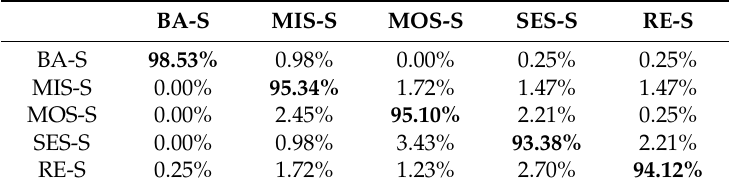
Table 6. Classification rates of K-ELM with integrated features (IT +